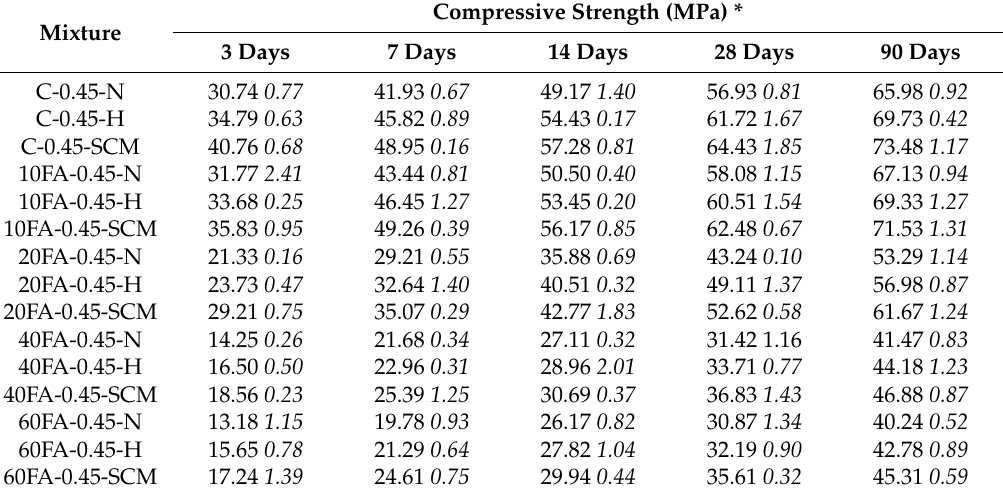
Table A3. Compressive strength for w/b 0.45.